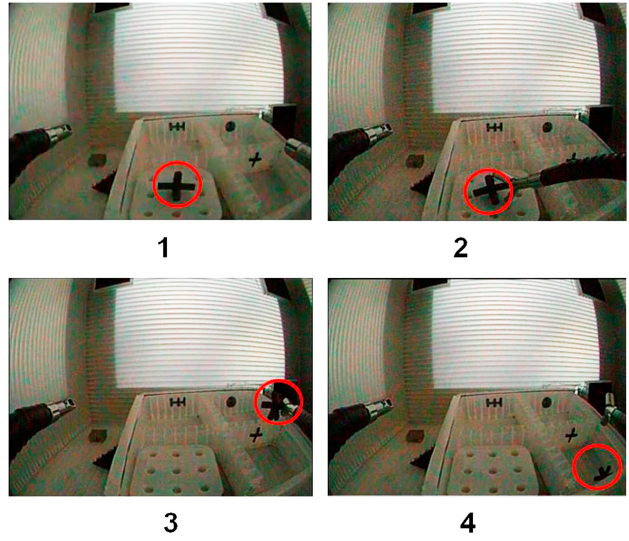
Figure 5. Image illustrations of each of the four steps, described verbally in Table 1, of the pick-and-drop task when performed with the right hand. At the beginning of each session, the object was replaced in the departure box at the same position and with the same orientation (see image 1, top left).